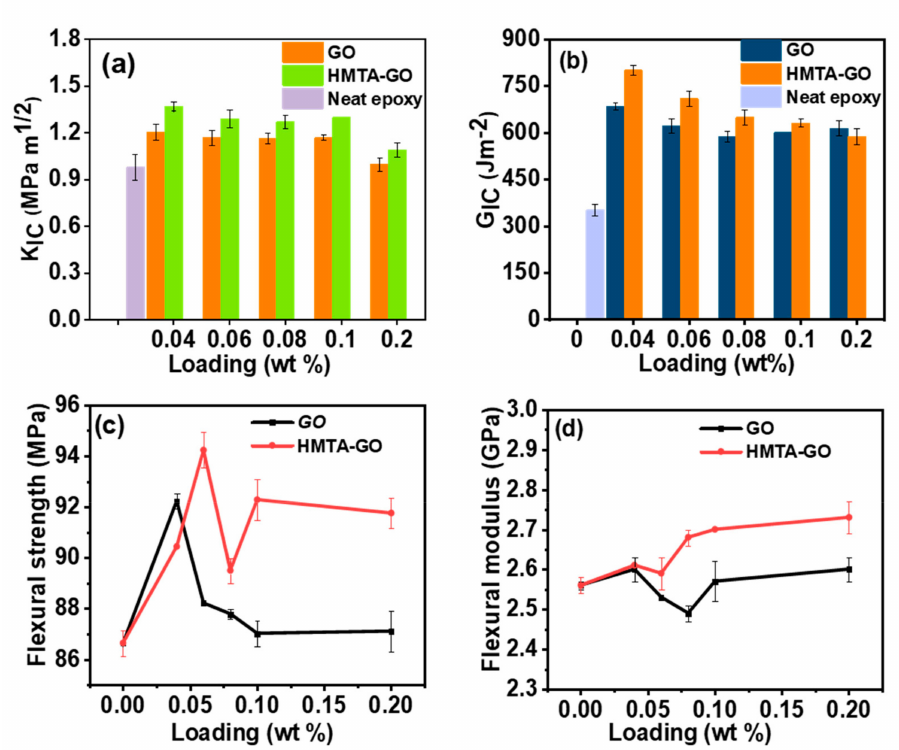
Figure 6. ( a ) Fracture toughness, ( b ) Fracture energy, ( c ) Flexural strength, and ( d ) Flexural modulus plots of epoxy